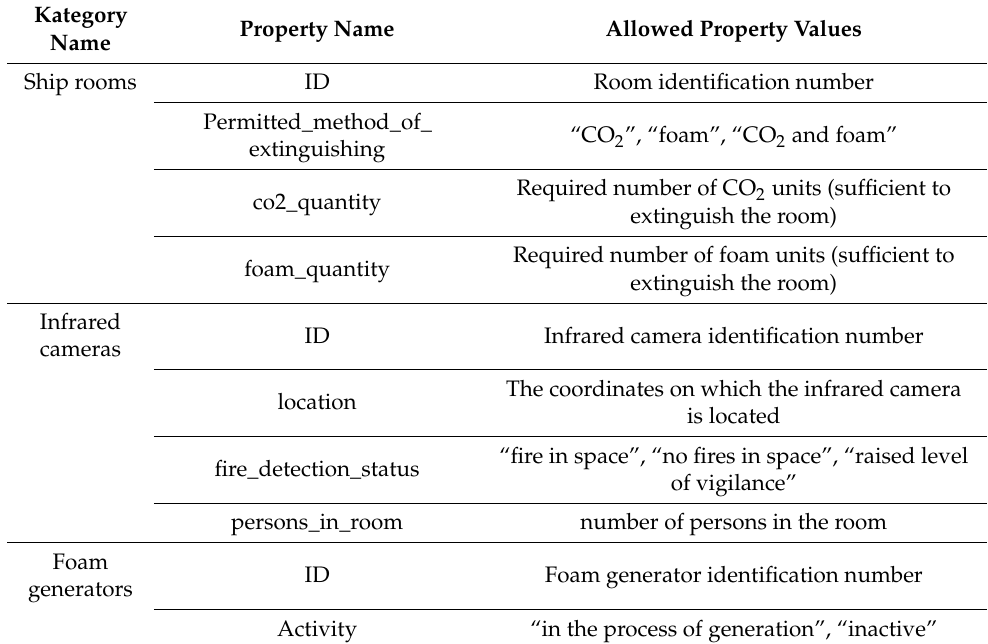
Table 1. Part of the categories (K) and their associated properties